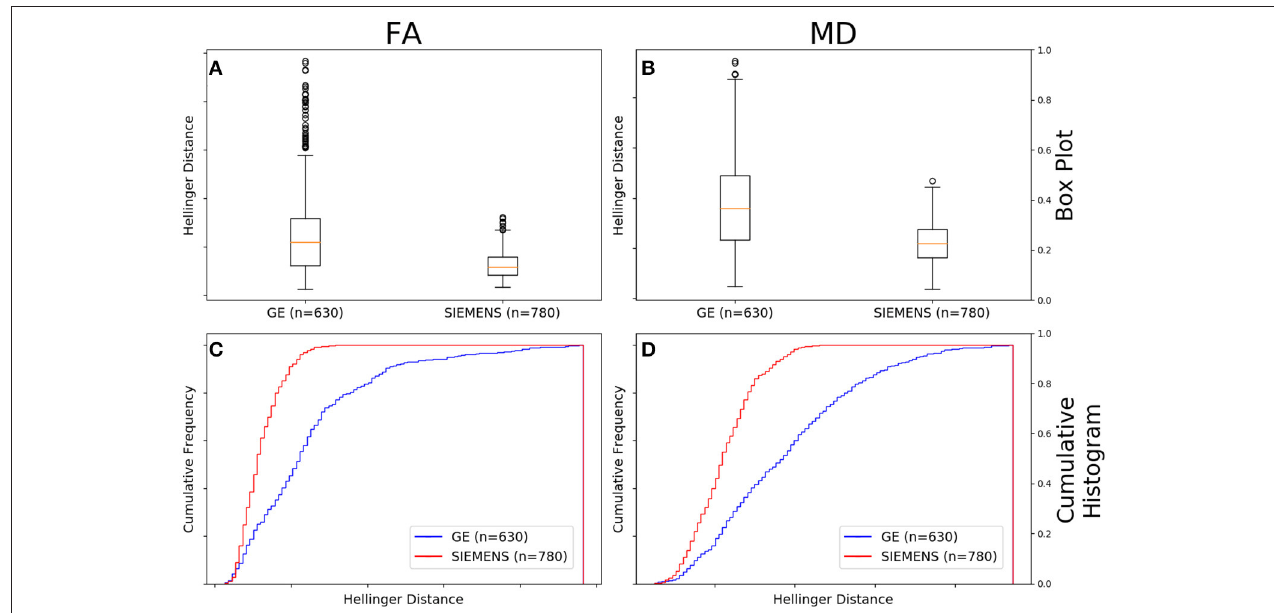
FIGURE 10 | FA (A) and MD (B) map box-and-whisker plot for GE (number of comparisons = 630) vs. Siemens (number of comparisons = 780) for 30 gradient directions, b = 1,000 s/mm 2 and 1.5T. Cumulative histograms for these data are shown for FA (C) and MD (D) .